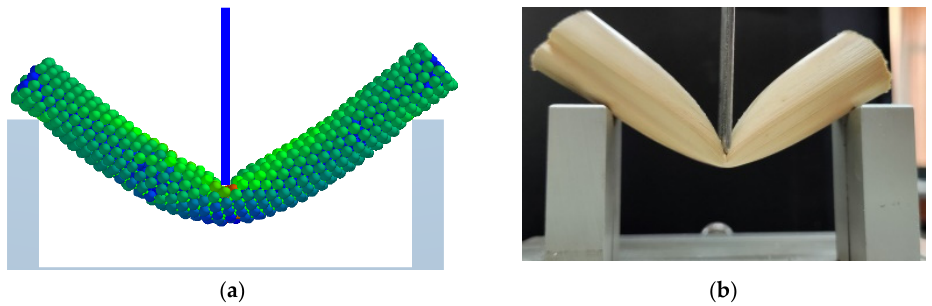
Figure 15. Whole straw bending test comparison. ( a ) Whole straw discrete element bending test; ( b ) whole straw physical bending test.